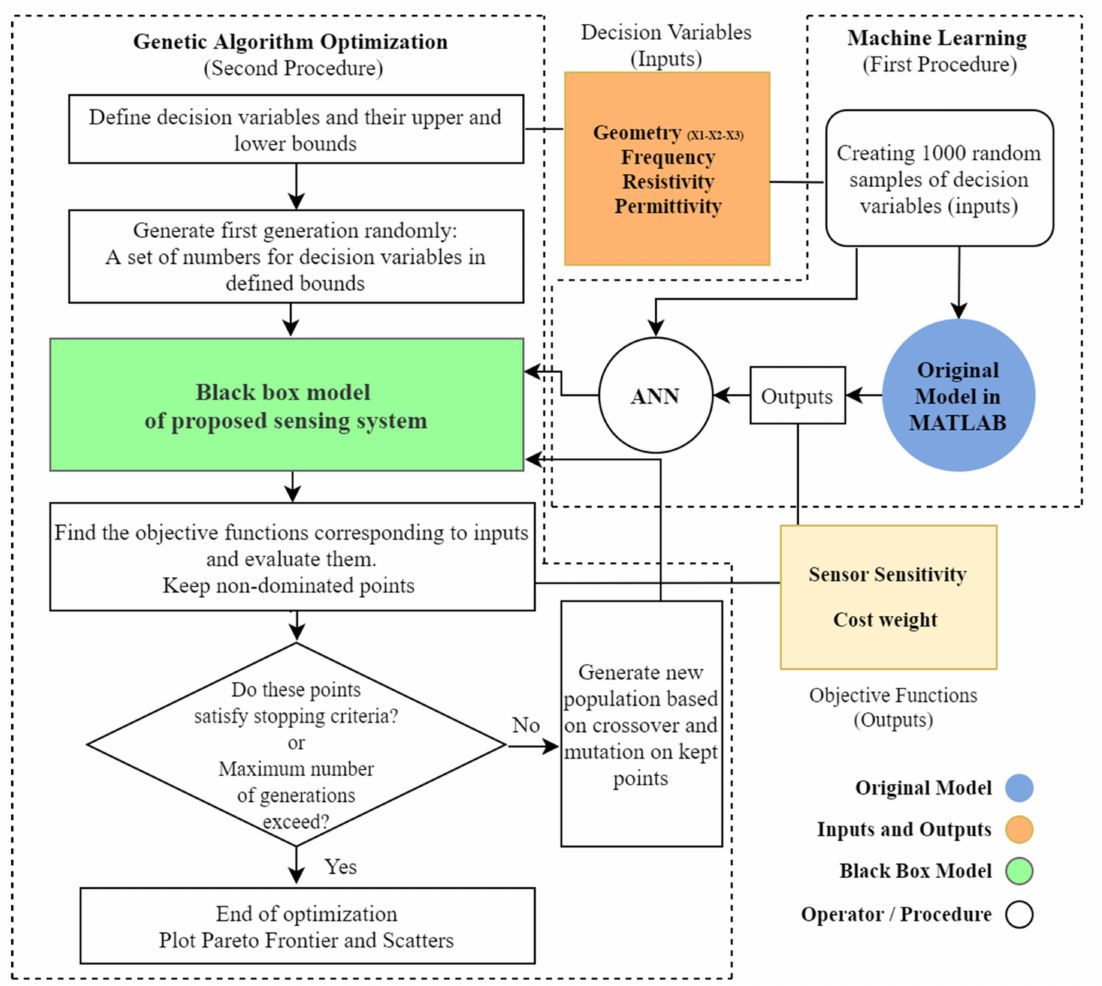
Figure 5. The flowchart of ANN and Genetic algorithm process and